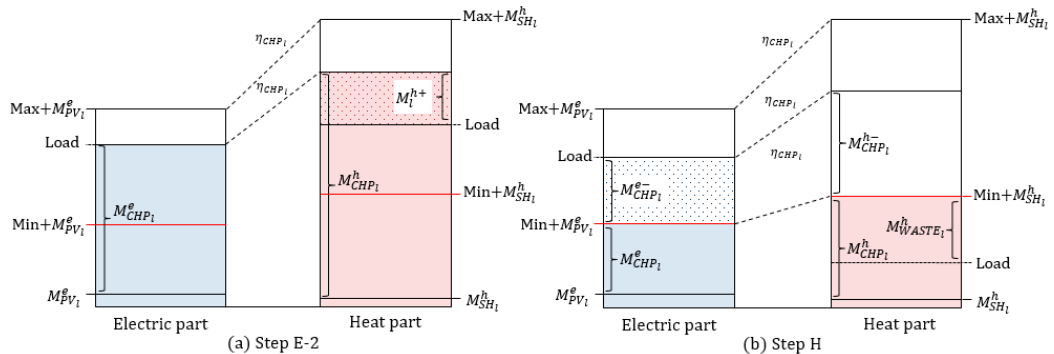
ř L p t q ą M h l “ 1 CHP ´ l